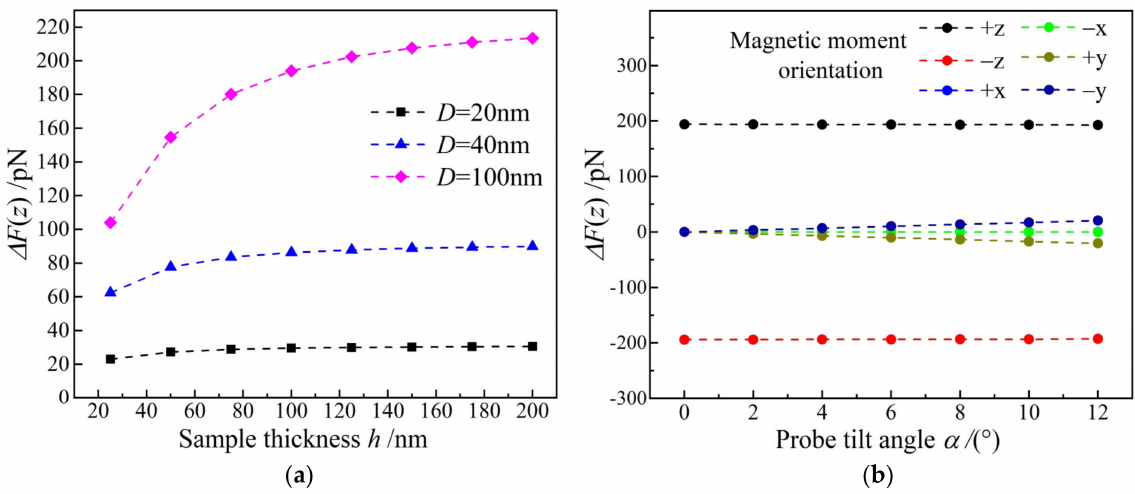
Figure 6. ( a ) Magnetic forces versus sample thicknesses for different sample diameters and a magnetic moment orientation along +z axis; ( b ) magnetic forces versus probe tilting angles along − y axis for samples ( h = 100 nm, D = 100 nm) with different magnetic moment orientations.